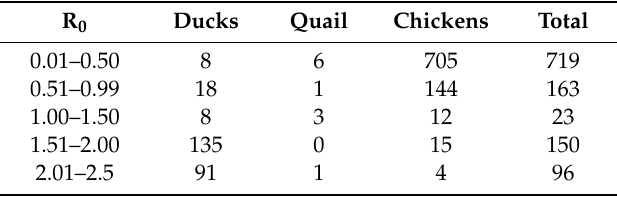
Table 2. Summary of farm-level basic reproductive ratio values.